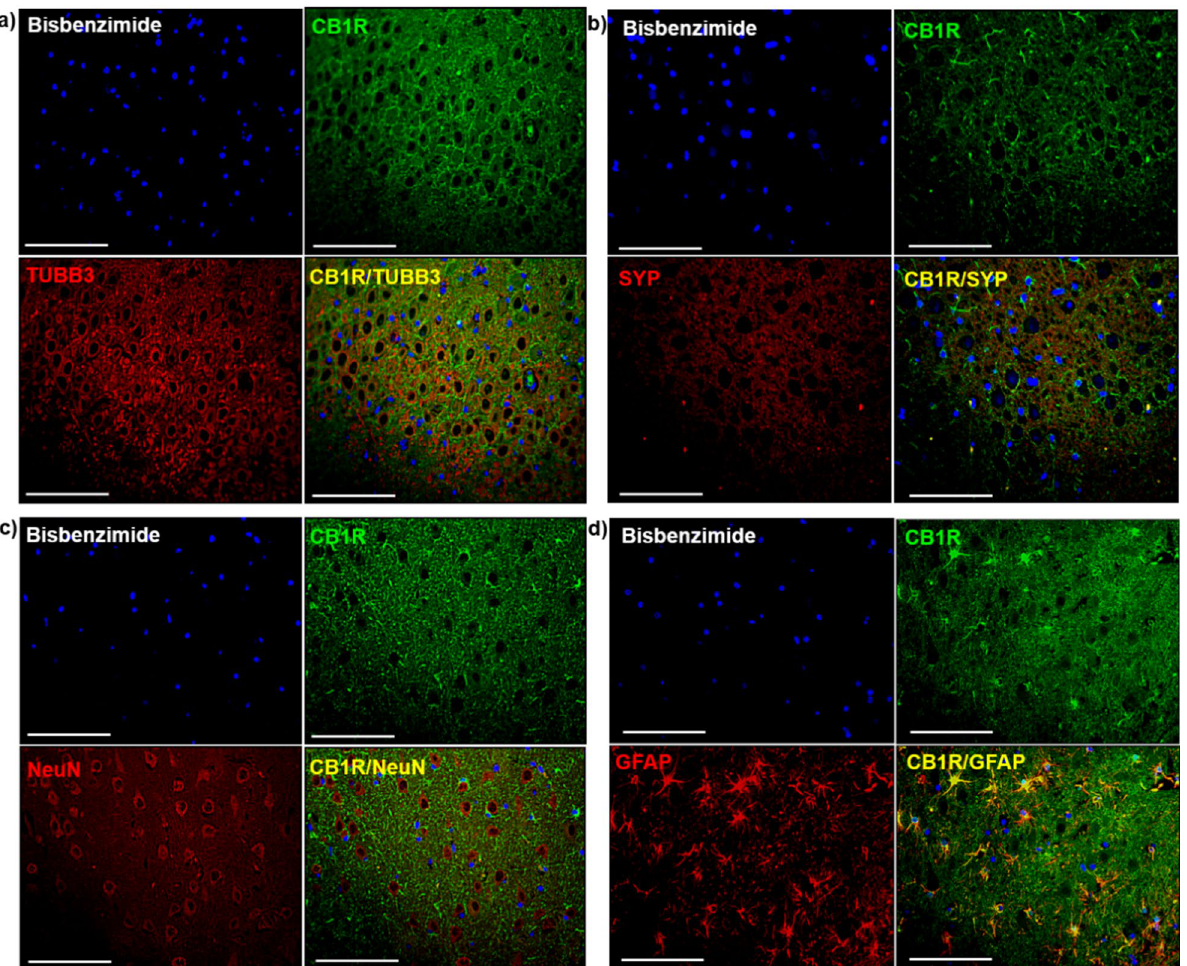
CB1R showed co-localization of both proteins (CB1RR/GFAP, yellow); ( a – d ) Bisbenzimide, nuclear staining (blue); Scale bar = 50 μm ( a – d ). CB1R: Cannabinoid receptor type 1; GFAP: glial fibrillary acidic protein; TUBB3: beta-tubulin III; NeuN: neuronal nuclei; SYP: